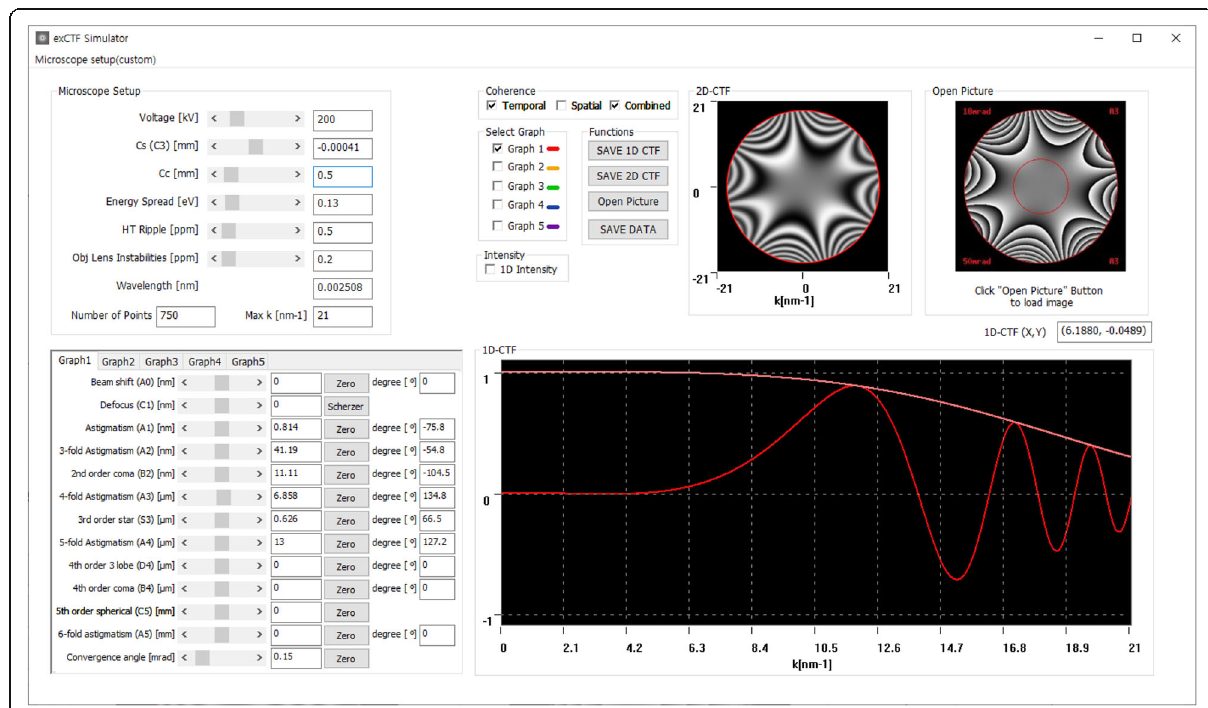
Fig. 4 CTF calculation results obtained using practical experimental data from an AC-TEM experiment. These results were calculated up to the third optical aberration coefficients considering the azimuth angles of each elemental